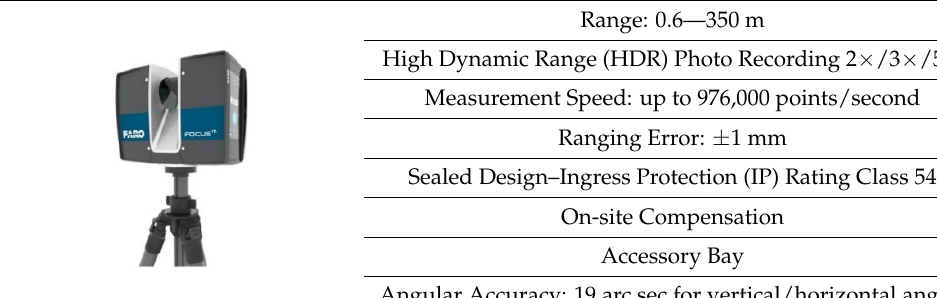
Table 1. Technical Information for FARO Focus S350 (https://echosurveying.com/3d-laser-scanner/ faro-focus-s350-laser-scanner, accessed on 24 November 2021).